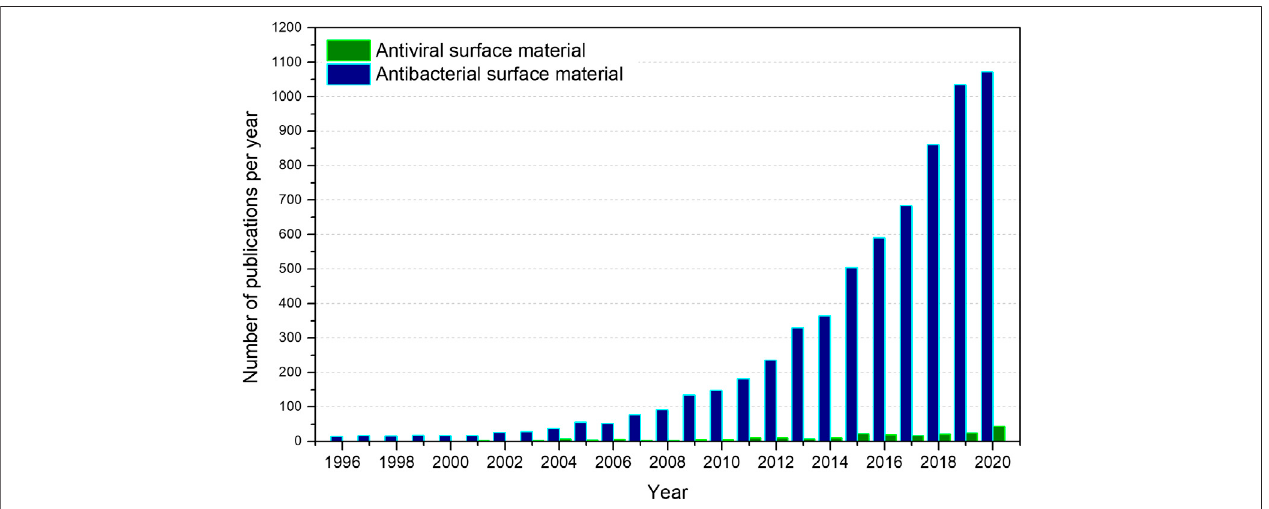
FIGURE 1 | Global number of scienti fi c publications over last 25 years obtained from the “ Web of Science-Clarivate Analytics ” database for “ antibacterial surface material; bactericidal surface material; bactericide surface material ” (antibacterial surface material) and “ antiviral surface material; virucidal surface material; virucide surface material ” (antiviral surface material). Search performed on November 26,